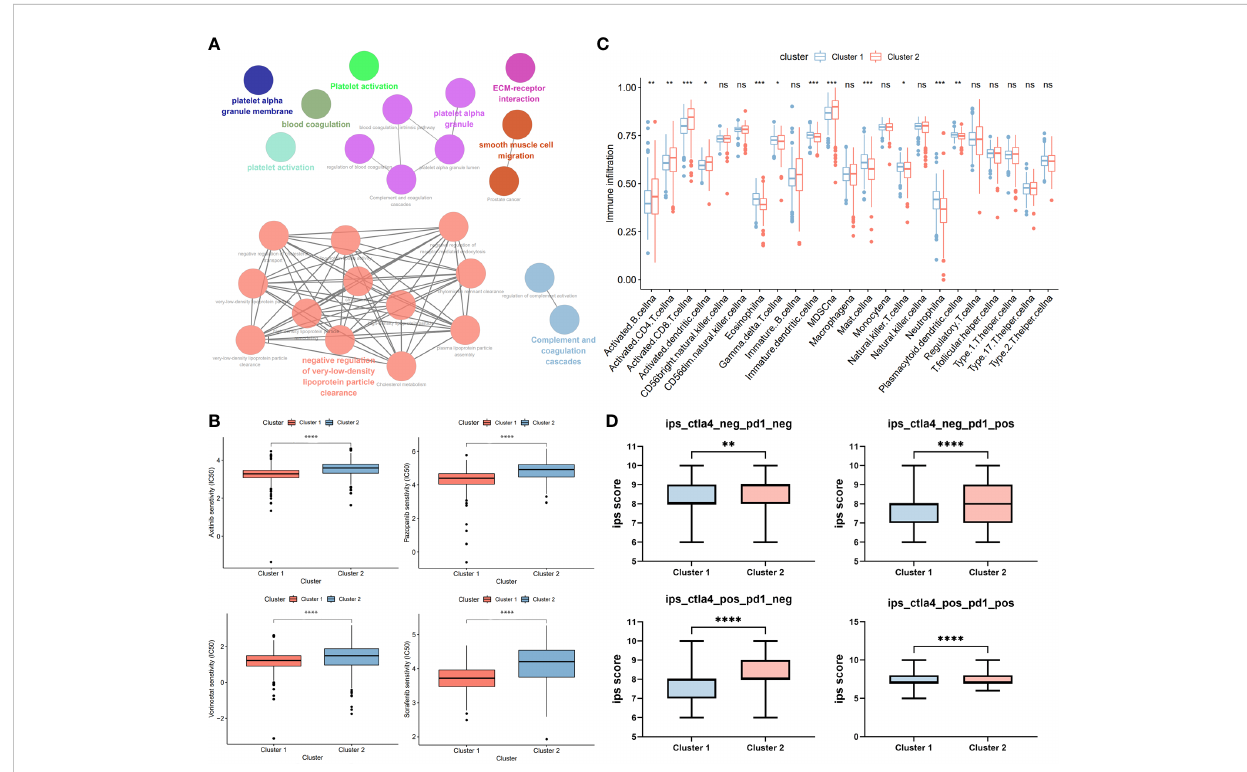
FIGURE 4 Phenotypic differences between clusters and potential individualized treatment. (A) The biological functional enrichment of differentially expression gene between two clusters in ClueGO plugin. (B) Drug sensitivity of commonly clinical used drugs for advanced ccRCC between clusters. (C) Differential analysis of immune cell in fi ltration between two clusters using ssGSEA method. (D) Relationship between differences in PD-1 and CTLA-4 responsiveness between the two groups, based on the TCIA database. GP style: *: p< 0.05; **: p < 0.01; ***:p<0.001; **** p<0.0001. n.s. = no signi fi cance.